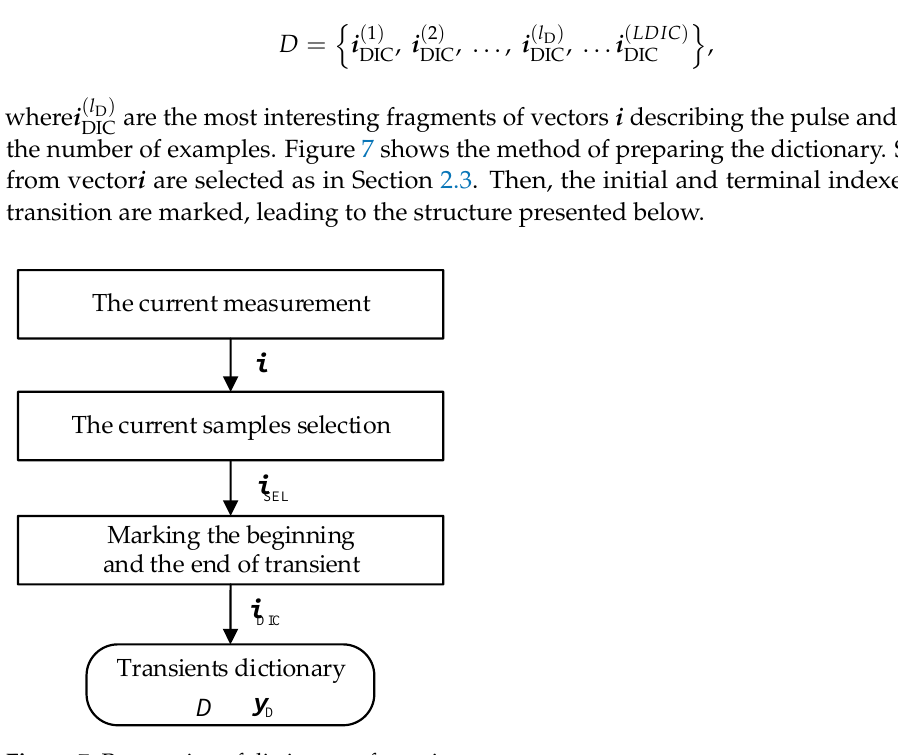
i for sample measurement data. Figure 6. Current vector i SEL for sample measurement data. S EL